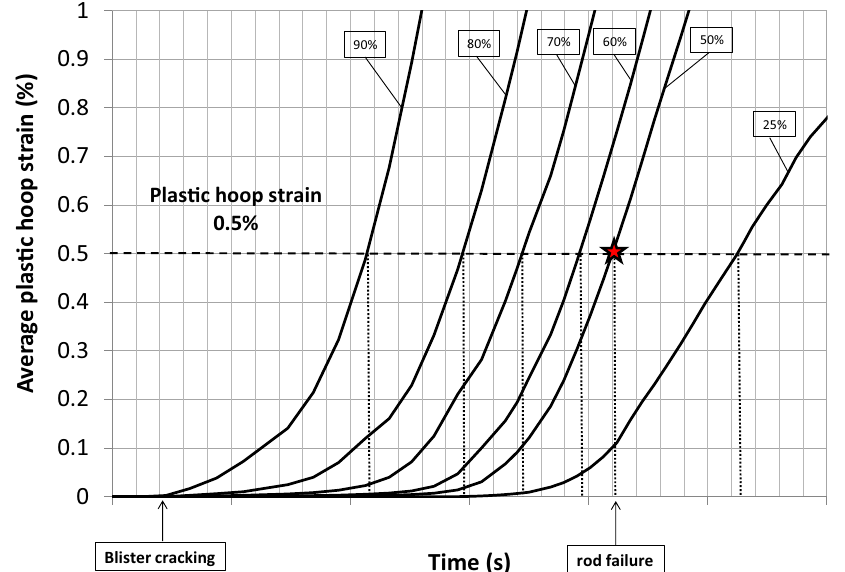
Fig. 8. Calculated evolution of the average plastic hoop strain in the 45 ° shear band during the REP-Na8 simulation in function of the hydride blister depth (in % of the clad